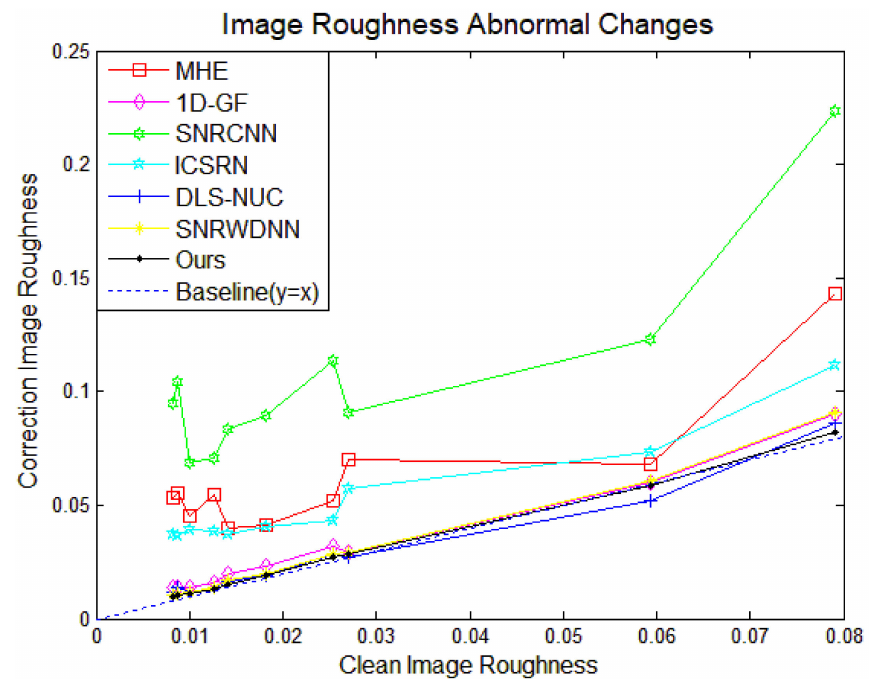
Figure 16. The line graph of each method performance on the IR. The abscissa is the clean image roughness, and the ordinate is the corrected image roughness. The better the fitting with the baseline, the lower the possibility of image over-smoothing.